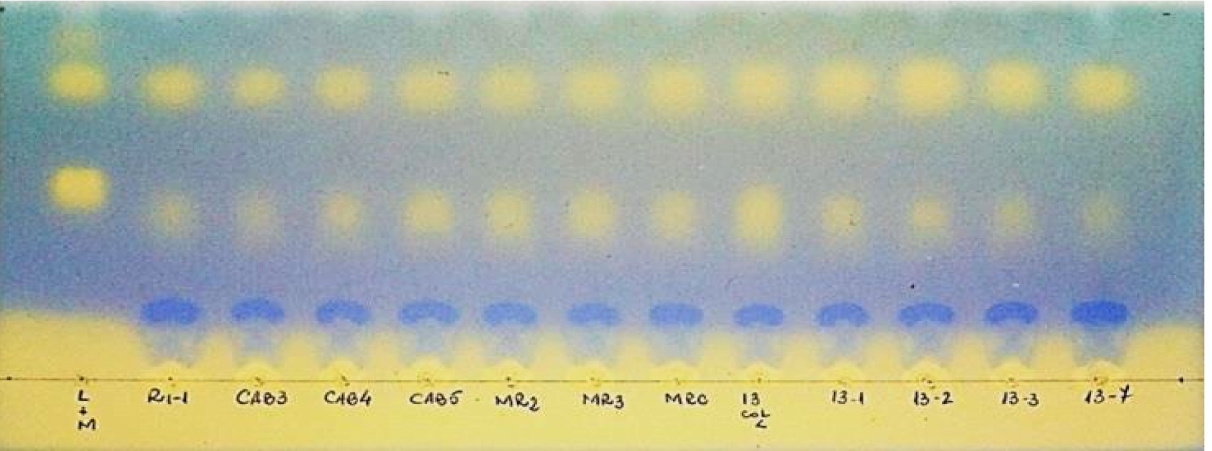
Figure 2. Thin layer chromatography of malic and lactic acids from synthetic wine (12% v/v ethanol) inoculated with lactic acid bacteria (20 days, 28 ◦ C). L + M-lactic acid (up) and malic acid (down) standards; R1-1... 13-7-bacterial